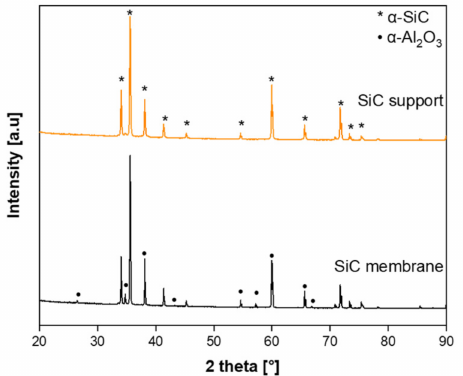
Figure 5. XRD patterns of the bare SiC support and the prepared SiC membrane layer on a SiC support.